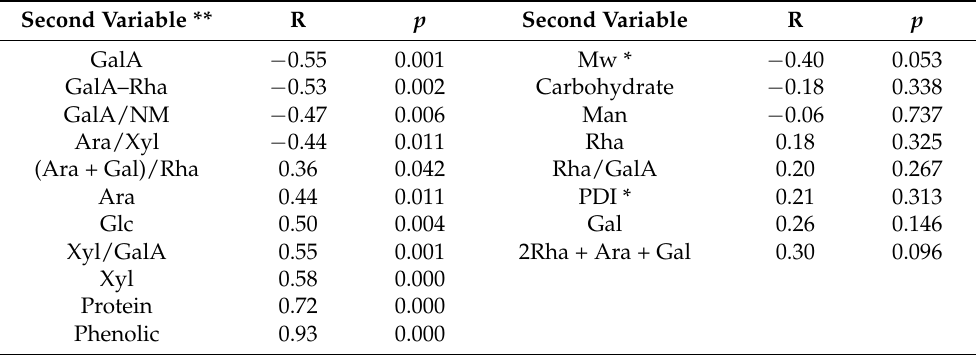
Table 6. The Pearson correlation coefficients between DPPH scavenging activity (in %) with the physicochemical characteristics of pectins and fractions ( n = 32). Second Variable ** R p Second Variable R p GalA − 0.55 0.001 Mw * − 0.40